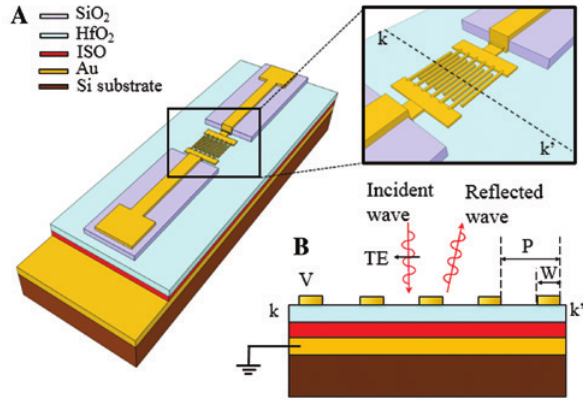
Figure 1: The gate-tunable metafilm absorber based on ISO. (A) 3D schematic of the metafilm absorber. (B) Cross section of the multi-layer structure describing operating